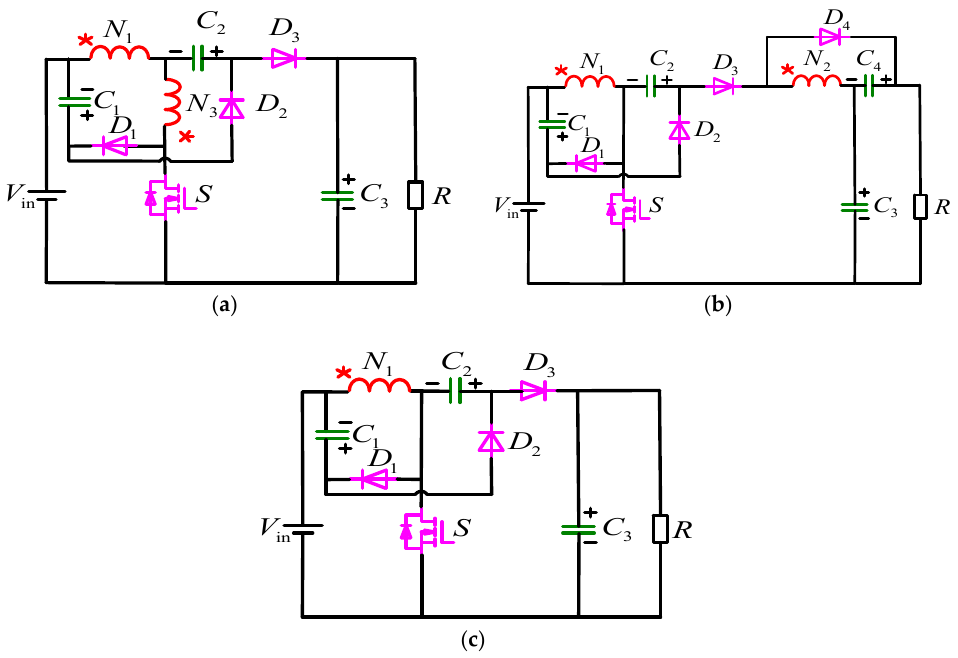
Figure 5. Derived converter: ( a ) Γ -shape coupled-inductor converter with voltage-double cell; ( b ) Γ -shape coupled-inductor converter with voltage-double cell; and ( c ) single inductor converter with voltage-double cell.